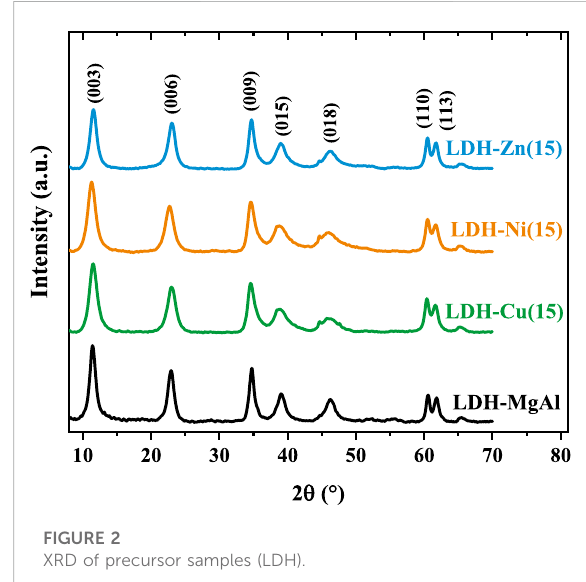
FIGURE 2 XRD of precursor samples